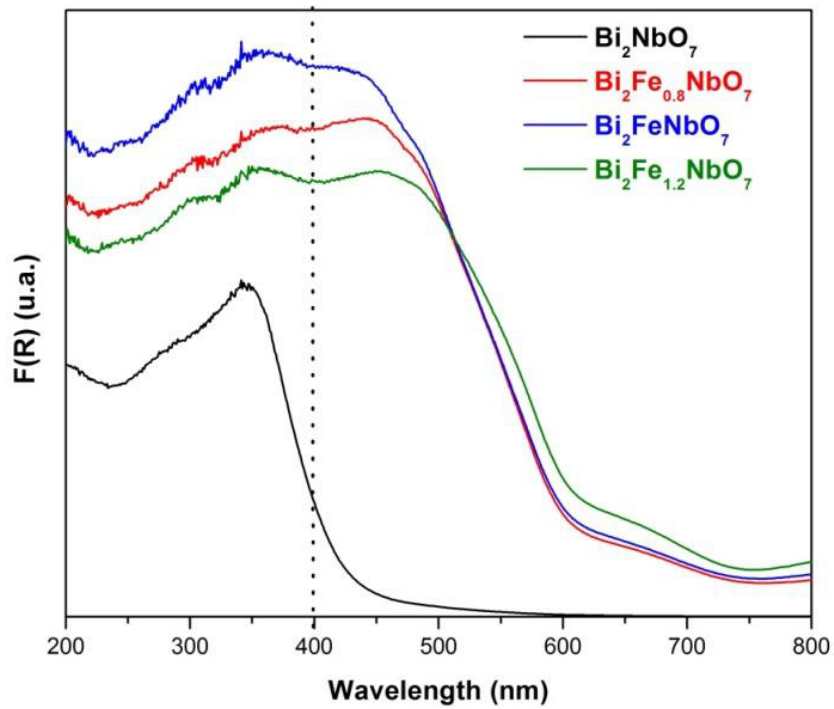
Figure 4. Diffuse reflectance UV-Vis spectra of Bi 2 Fe x NbO 7 catalysts plotted as Kubelka-Munk function F(R) of the reflectance,